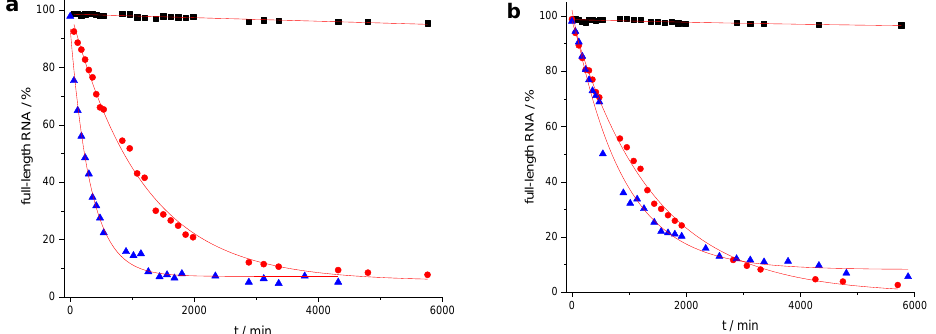
Figure 3. Determination of rate constants: 150 nM of RNAs 8 or 9 were incubated with 3 µM of 10 and 11 , or with 750 nM of 12 and 13 (50 mM Tris buffer (pH 8.0), 37 °C). The amount of residual full-length RNA is shown as a function of time. Representative examples of single experiments are shown, and the data were fitted to a first-order rate model (single exponential decay). Derived mean values of k max (calculated from three independent experiments) were accurate within ±15%. ( a ) Reaction of RNA 8 with conjugates 10 (red circles) and 12 (blue triangles). ( b ) Reaction of RNA 9 with conjugates 11 (red circles) and 13 (blue triangles). Black squares: RNAs 8 and 9 incubated under the same conditions in the absence of conjugate.